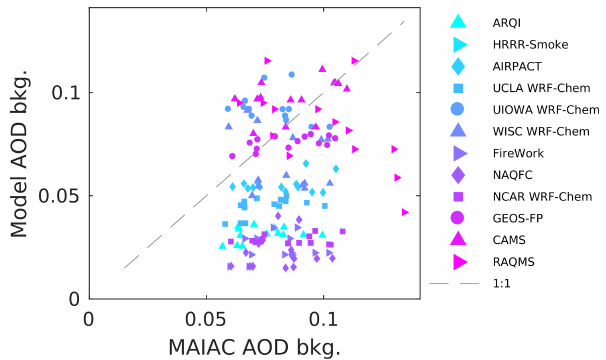
Figure 6. Scatter plot of background AOD values derived from MODIS MAIAC AOD data and modeled results per hourly scene during 4–8 August 2019. Note that the background of HRRR- Smoke is clean since it does not include non-smoke